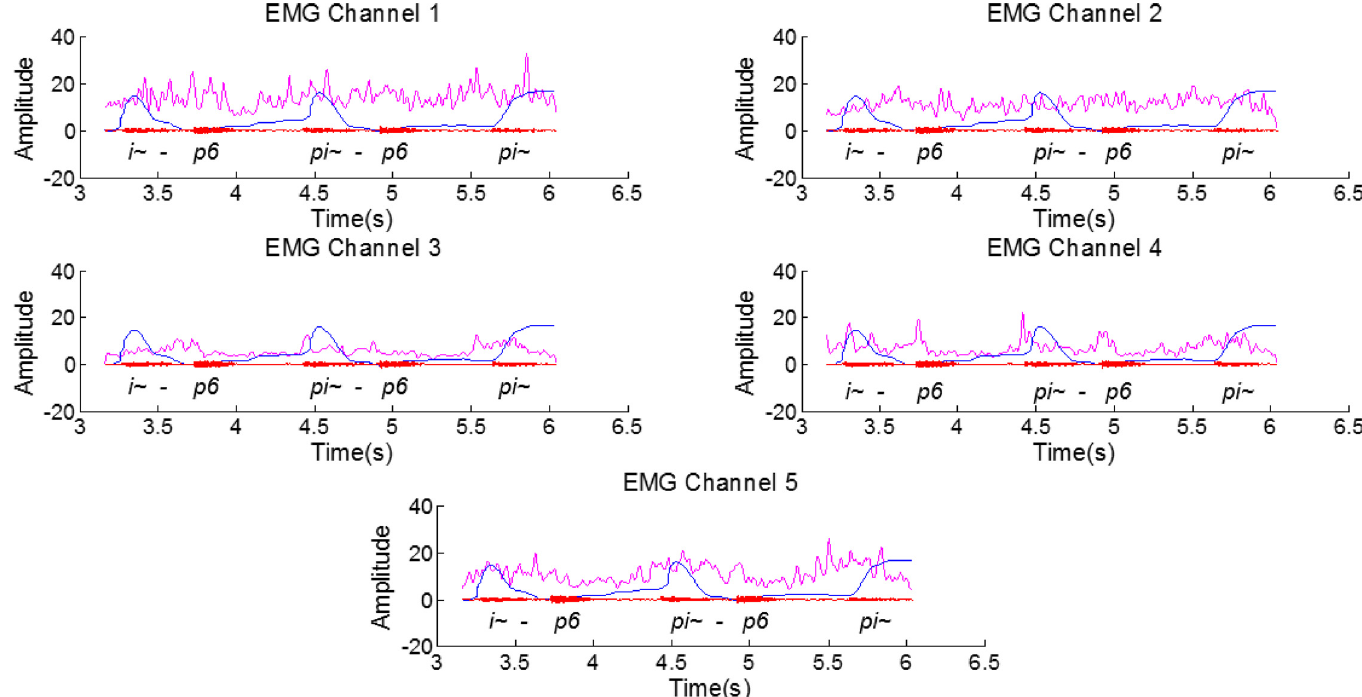
Fig 9. Filtered EMG signal (12-point moving average filter) for the several channels (pink), the aligned RT-MRI information (blue) and the respective audio signal for the sentence [i~p6, i~p6, pi~] from speaker 1. An amplitude gain was applied to the RT-MRI information and to the EMG for better visualization of the superimposed